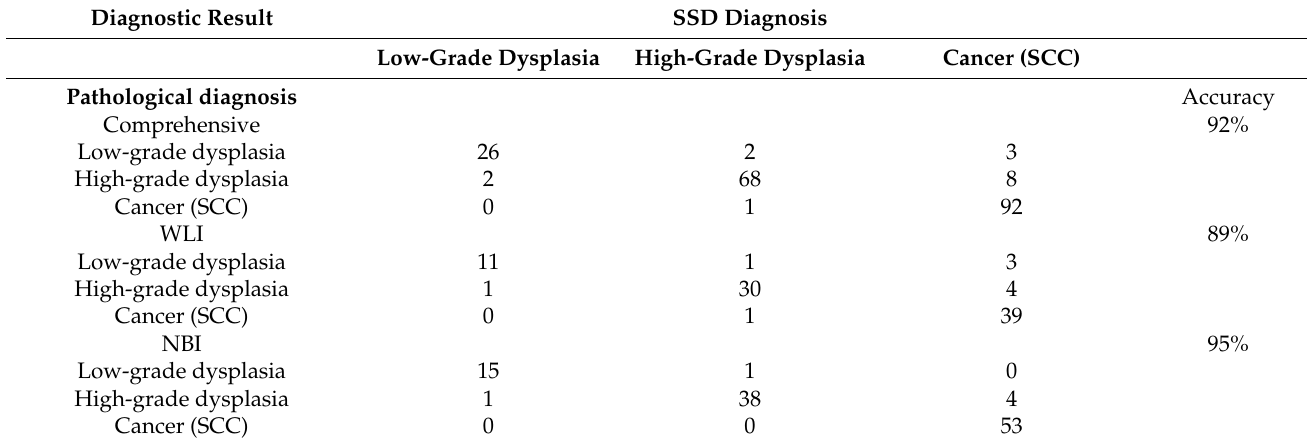
Table 3. Detailed results of SSD in diagnosing different histological grades of esophageal neoplasms. Diagnostic Result